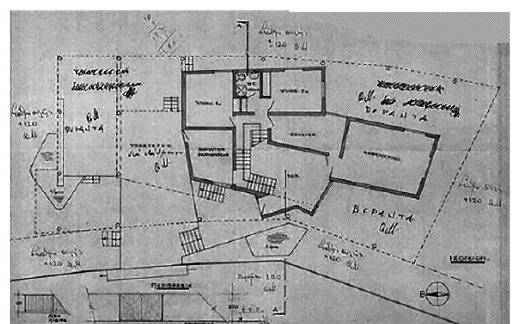
Figure 7. Ground floor plan / Neoptolemos and Maria